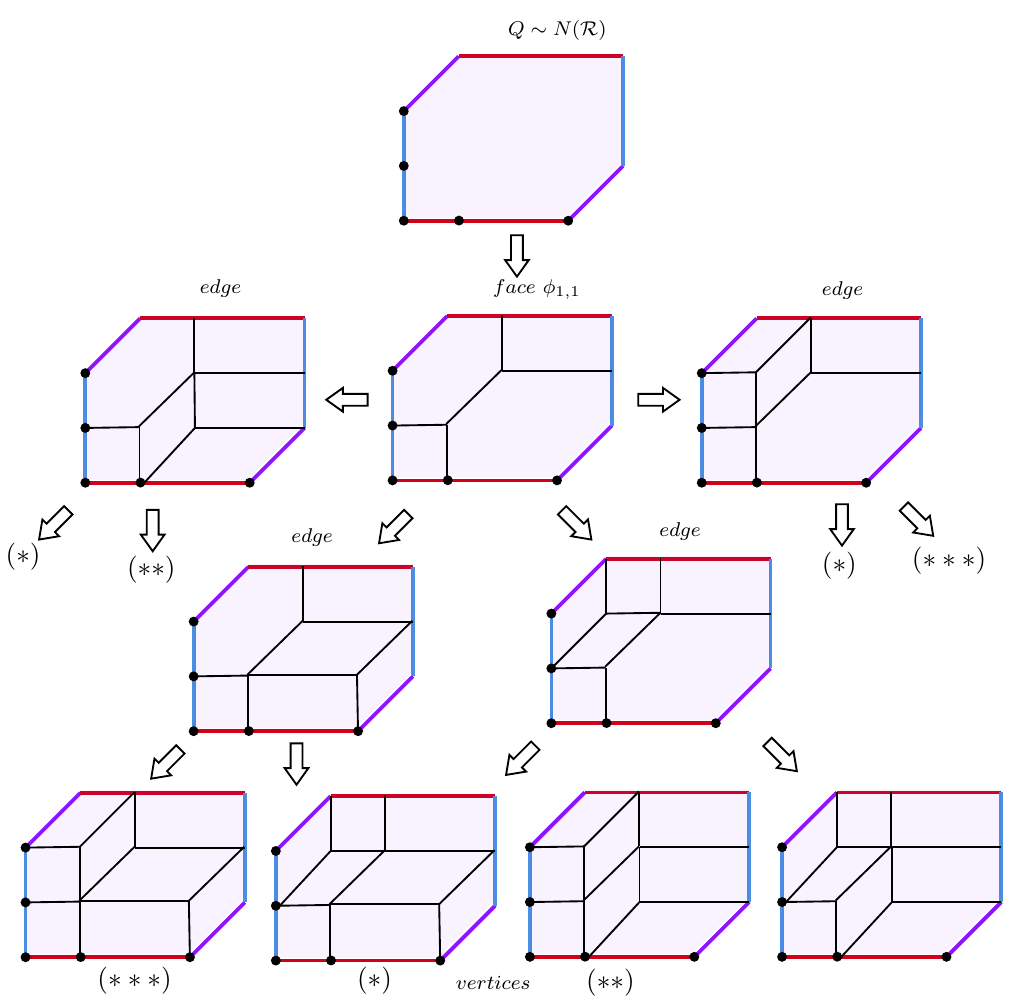
Figure 18 . Detalization of (cid:30) 1 ; 1 : the complete